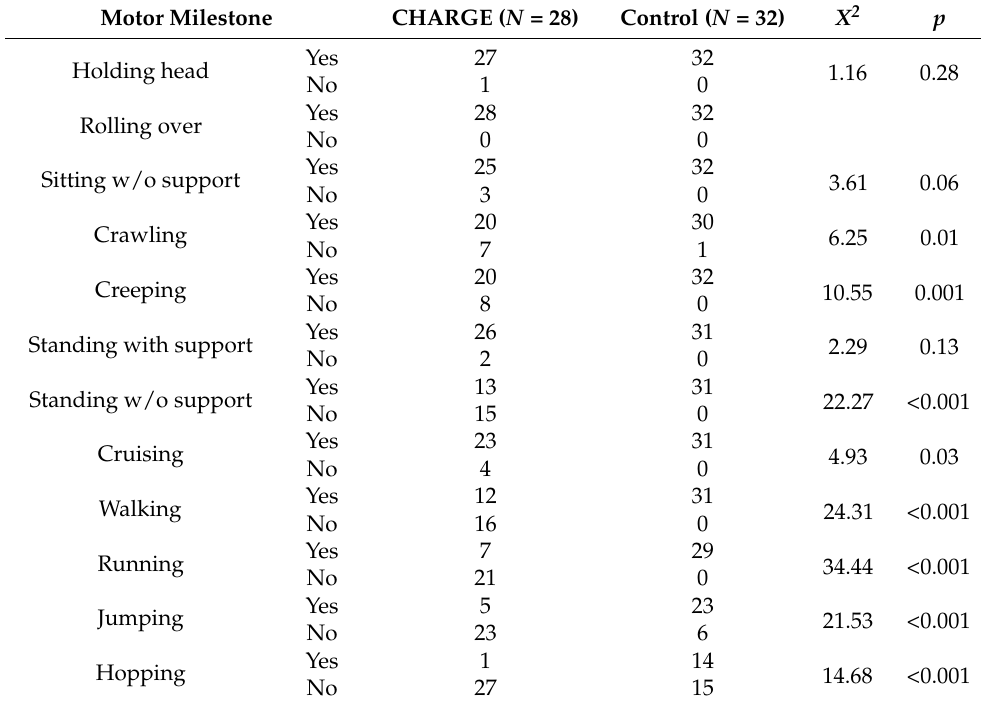
Table 3. Cross tabulation of children with and without CHARGE syndrome and achievement of motor milestones.